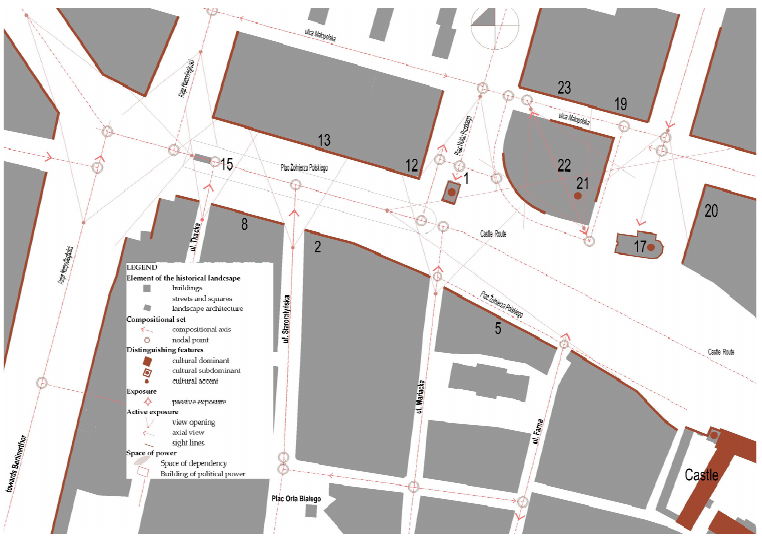
Figure 11. Landscape analysis of plac ˙Zołnierza Polskiego in 2020. The spatial arrangement was corrected in relation to Figure 10. The public space was moved from plac ˙Zołnierza Polskiego into the space of plac Solidarno´sci. The main compositional axis of this urban interior run diagonally, linking the new philharmonic building (23) with the spatial accent–the castle tower. The space of authority around both urban interiors was eliminated as a result of it being given new public functions (12, 13, 19). Despite the development of aleja Kwiatowa (15), plac ˙Zołnierza Polskiego has a dominant function of communication in its central part. Plac Solidarno´sci has thus become a space of post-dependence and emancipation (source: created by author).